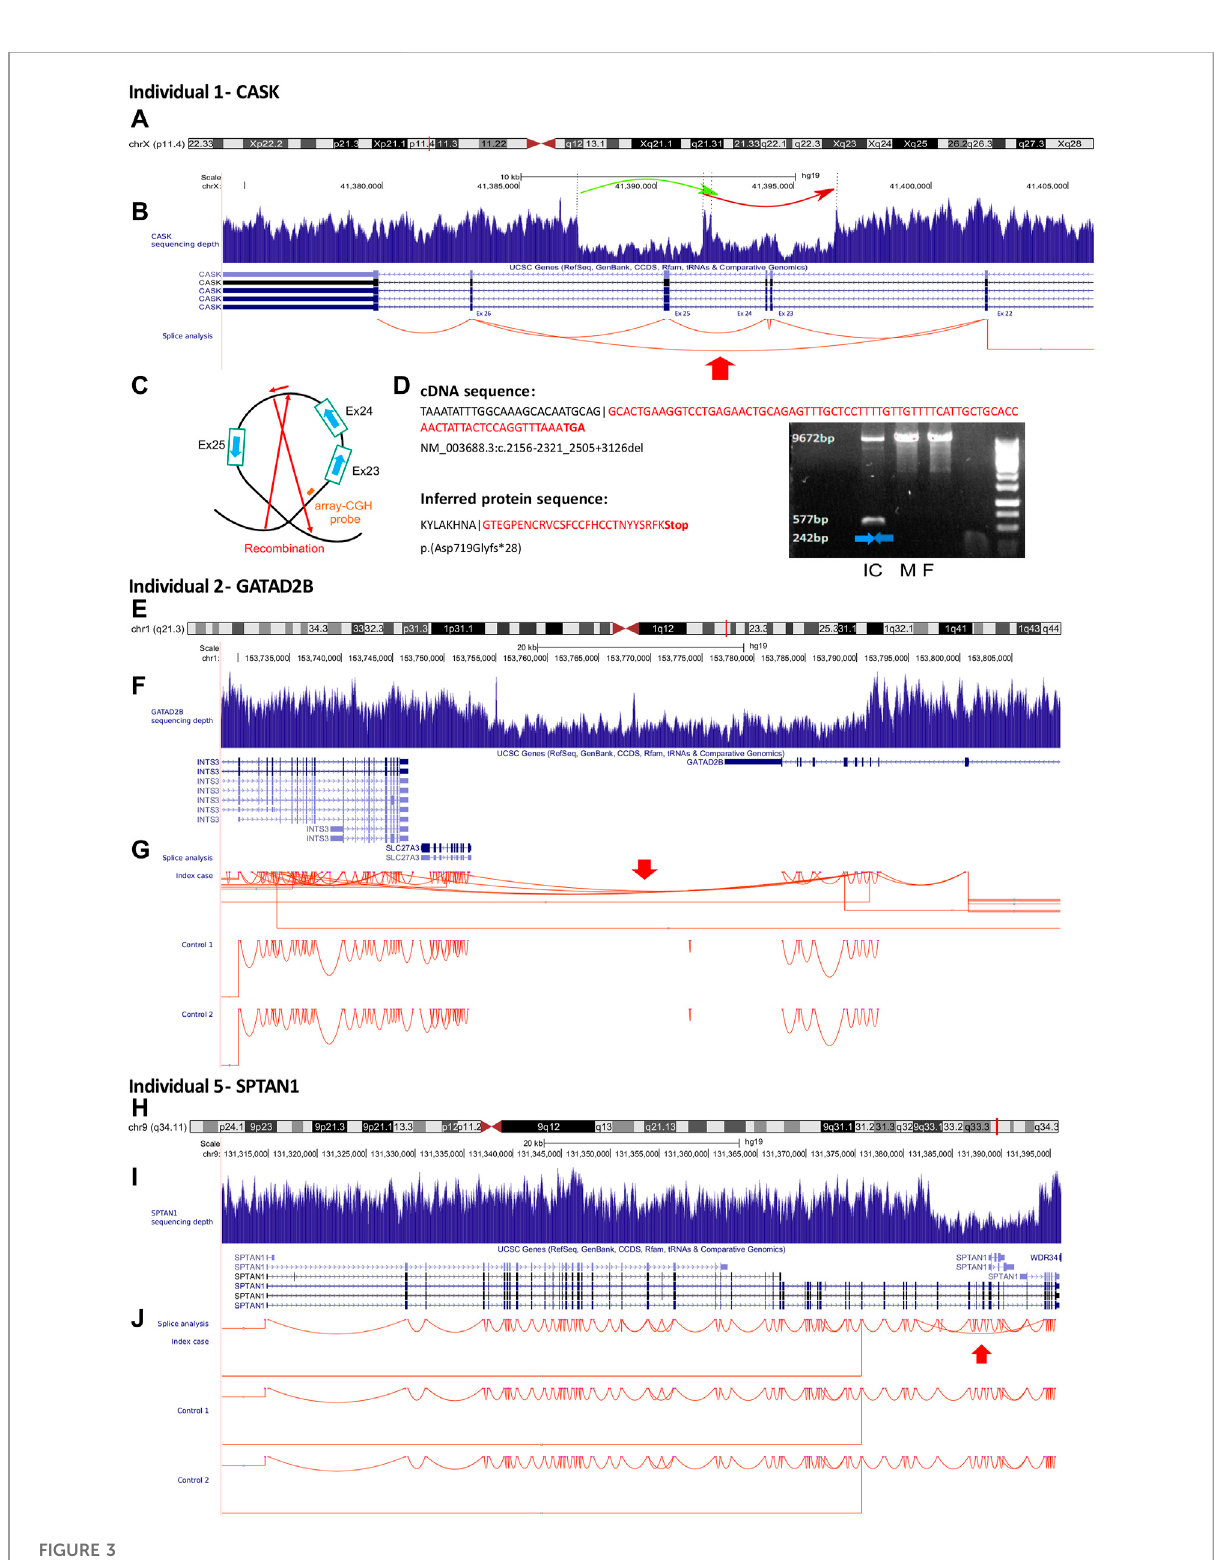
FIGURE 3 Illustration of individuals 1 — CASK, 2 — GATAD2B, and 5 — SPTAN1. (A) Ideogram showing chromosome X and CASK localization. Under the ideogram, the green and red arrows represent the deletion-inversion of 9.4 kb in Xp11.4. (B) UCSC genome browser snapshot with visualization of CASK sequencingdepth and CASK splice analysis. CASK sequencingdepth demonstrates anintragenicdeletionencompassing exons 23through25. The red arrow in the splicing analysis demonstrates the presence of a heterozygous transcript lacking exons 23 through 25. (C) Graphic